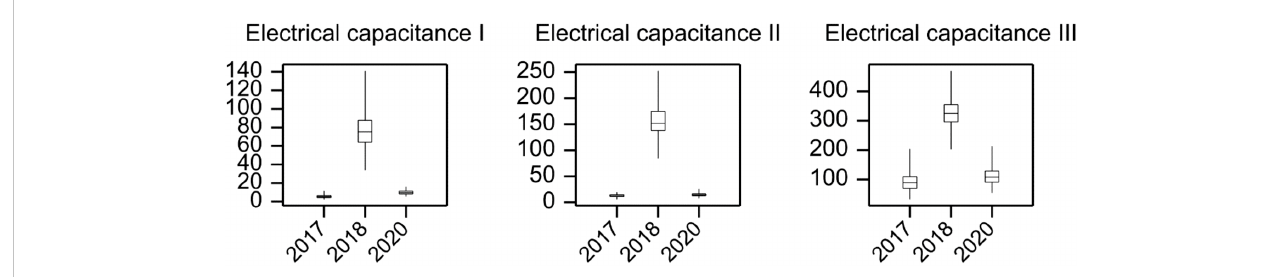
FIGURE 2 Electrical measurement results for the studied accessions. Electrical capacitance (pico farad – pF) was measured three times - in tillering stage (T1), stem elongation stage (T2) and heading stage (T3).